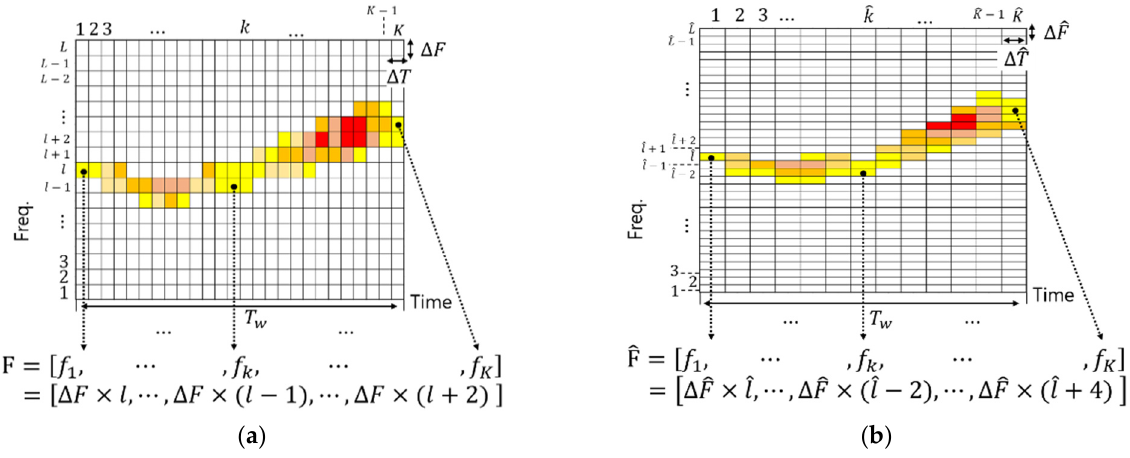
Figure 2. Example of the STFT results of whistles with various ∆ T and ∆ F : ( a ) STFT with ∆ T and ( b ) STFT with ∆ ˆ T